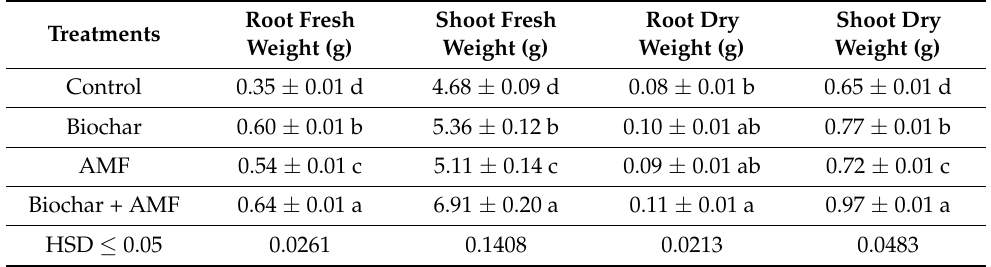
Table 2. Impact of biochar and AMF on fresh and dry weights of root and shoot of fenugreek. Treatments